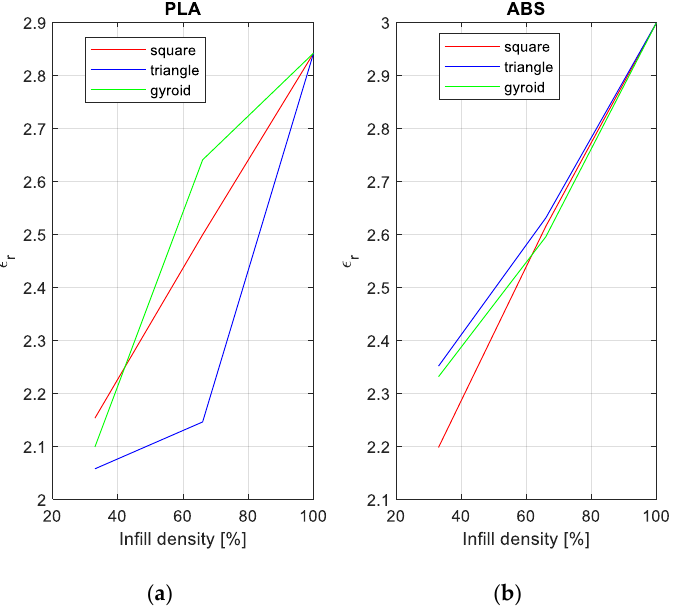
Figure 3. Results of relative dielectric constant measurements with various infill densities: ( a ) PLA filament, ( b ) ABS filament.